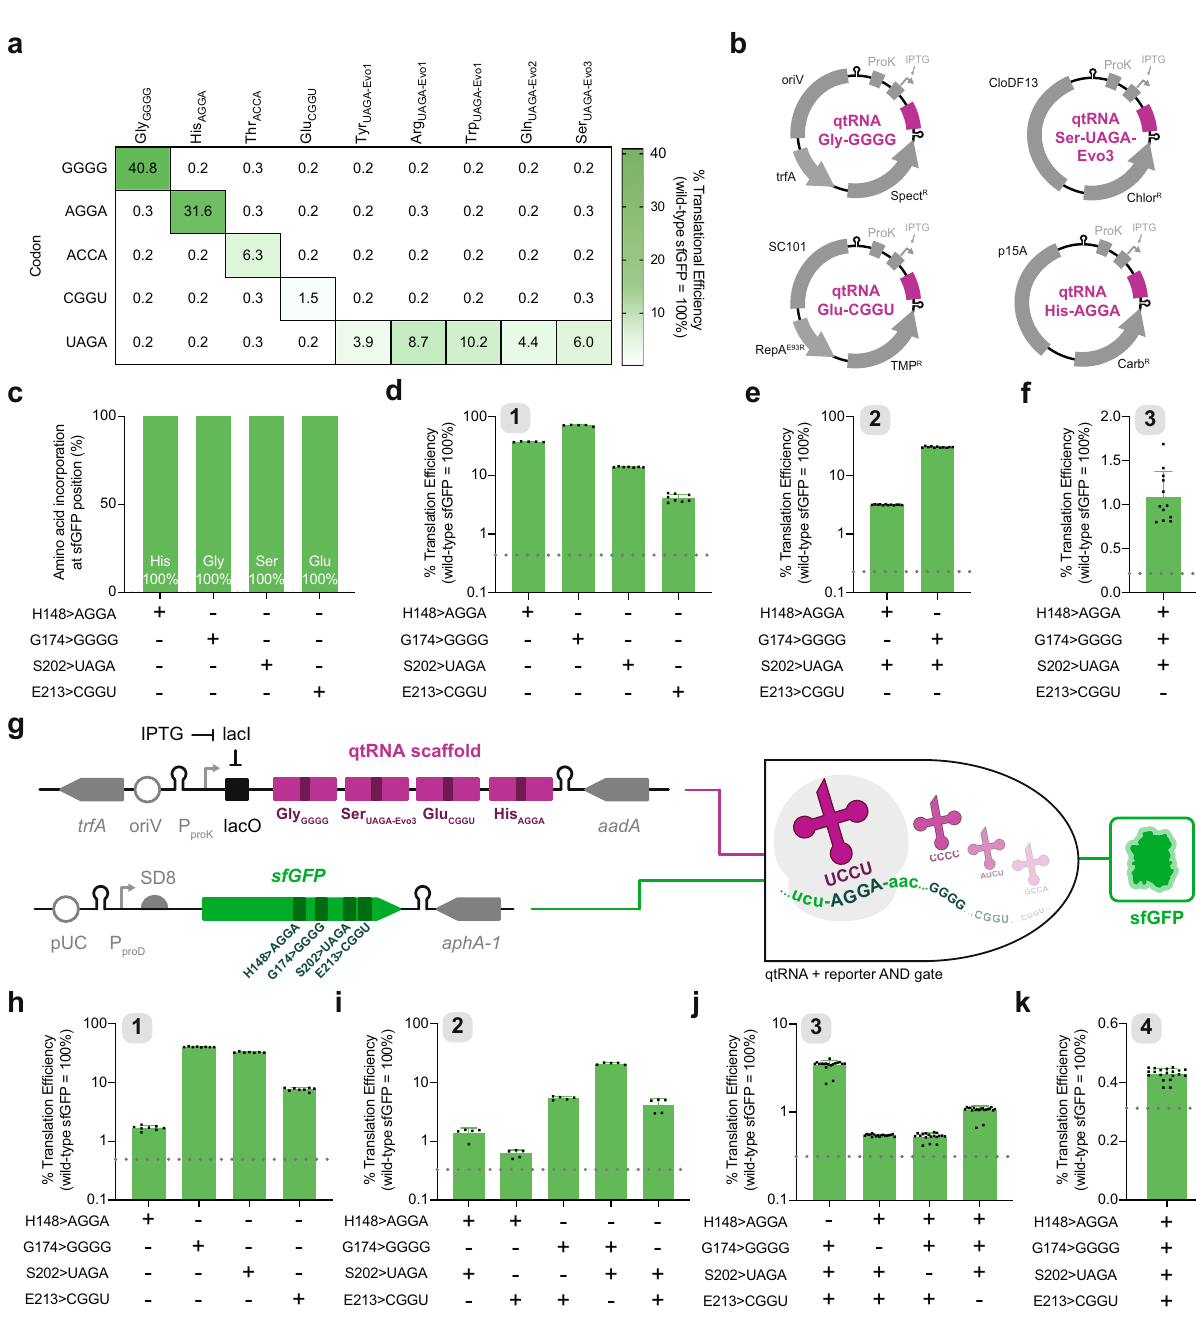
Fig. 5 Multiplex quadruplet codon suppression in sfGFP. a Engineered and evolved qtRNAs showcase robust mutual orthogonality position Y151 of sfGFP. Expected codon-qtRNA interactions are outlined. b Schematic representation of orthogonal qtRNA expression plasmid architecture, including qtRNA, plasmid origin, and antibiotic resistance markers. c The sfGFP reporter previously described was fi rst used to quantify amino acid incorporation at positions throughout sfGFP via mass spectrometry. Comprehensive peptide fragmentation spectra are reported in Supplementary Figure 11 and summary LC-MS/MS results are reported in Supplementary Table 8. Using a reporter with unique quadruplet codons in sfGFP alongside orthogonal qtRNA expression plasmids encoding qtRNA Gly GGGG , qtRNA Ser UAGA -Evo3, qtRNA Glu CGGU , and/or qtRNA His AGGA enables the translation of one ( n = 5 biologically independent samples except for S202 > UAGA n = 7 and E213 > CGGU n = 8) ( d ), two ( n = 12 and n = 11 biologically independent samples, respectively) ( e ), and three ( n = 12) ( f ) unique quadruplet codons in a single reporter gene. g Schematic representation of the engineered multicistronic qtRNA scaffold and reporter plasmid encoding multiple quadruplet codons in sfGFP. Production of full-length sfGFP is dependent on the translation of up to four quadruplet codons. Expression of qtRNA Gly GGGG , qtRNA Ser UAGA -Evo3, qtRNA Glu CGGU , and qtRNA His AGGA from a single multicistronic qtRNA scaffold enables the translation of one ( n = 8 biologically independent samples except for S202 > UAGA n = 7) ( h ), two ( n = 5 biologically independent samples) ( i ), three ( n = 18 biologically independent samples except for H148> AGGA/G174> GGGG/S202 > UAGA n = 20) ( j ) and four ( n = 20 biologically independent samples) ( k ) quadruplet codons in sfGFP. Comprehensive peptide fragmentation spectra are reported in Supplementary Figs. 14 – 17. In all cases, reporter data is normalized to an otherwise wild-type protein and color-coded by the used reporter. Dotted lines on each plot represent strain auto fl uorescence and gray boxes in the upper left corner of certain plots re fl ect number of quadruplet codons. Data represent the mean and standard deviation as